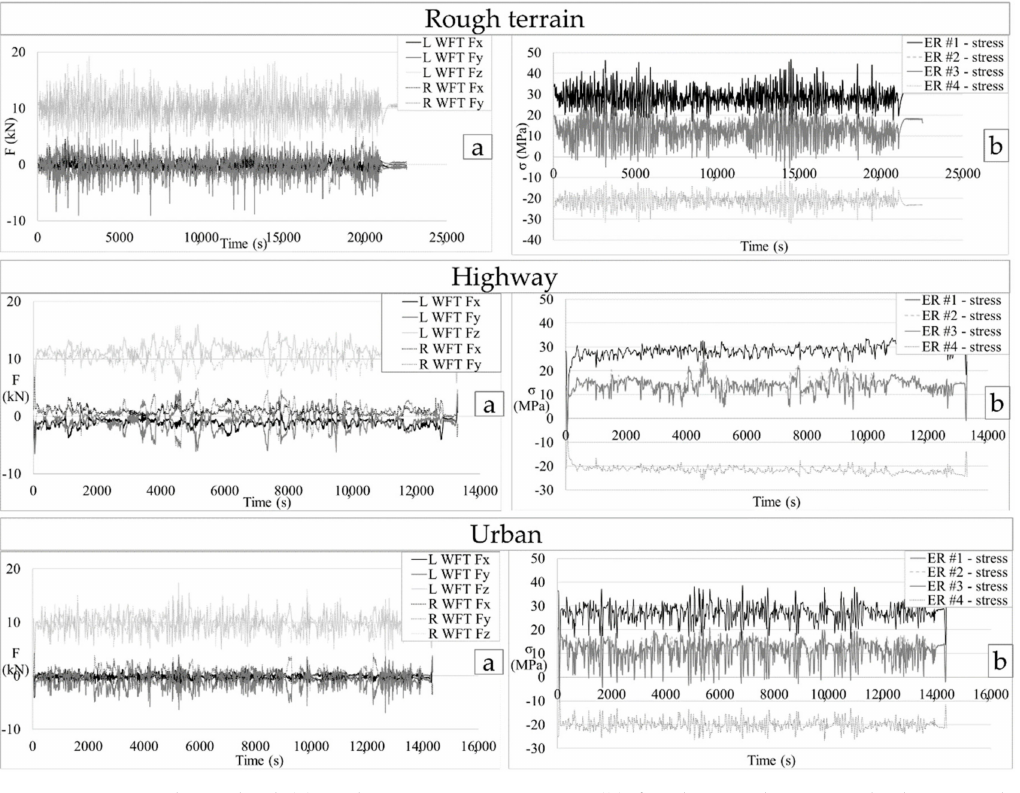
Figure 10. Load at wheel ( a ) and strain gauge outputs ( b ) for the rough terrain, highway and urban missions.